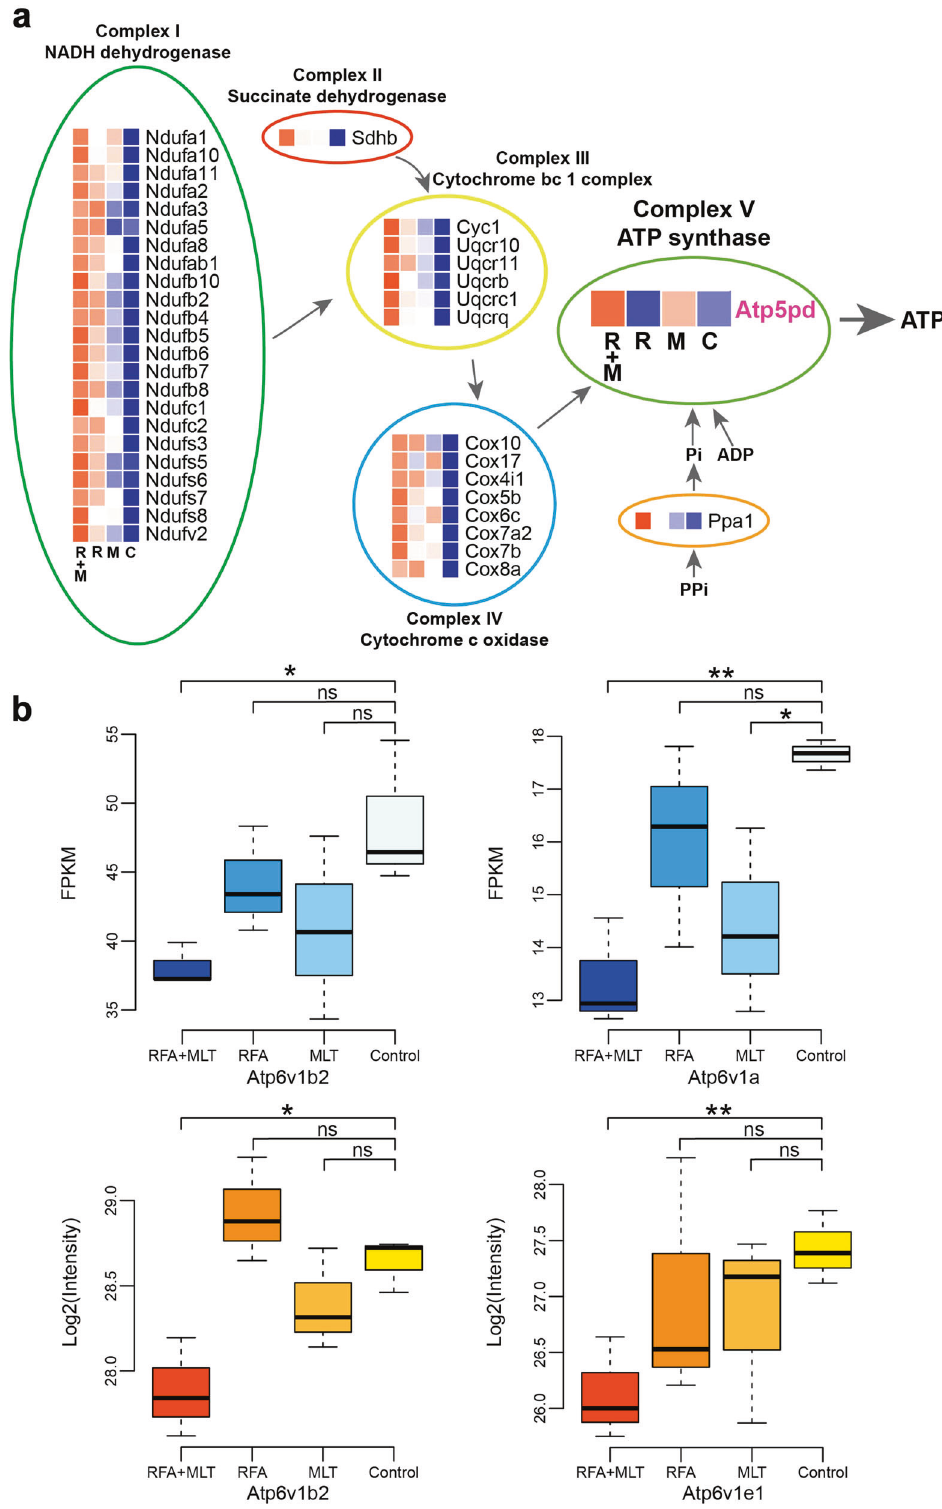
Fig. 6 Multi-omics comprehensive analysis revealed genes and proteins that potentially correlate with mitochondrion in the RFA + MLT groups. a The integrative multi-omics data analysis of genes (black) and proteins (purple) related to Complex I, Complex II, Complex III, Complex IV, and Complex V in mitochondrion (FC > 1.2, P ≤ 0.05). b Boxplots representing the expression levels of V-ATPase-relevant genes (blue) and proteins (orange) in the RFA + MLT, RFA, MLT, and Control